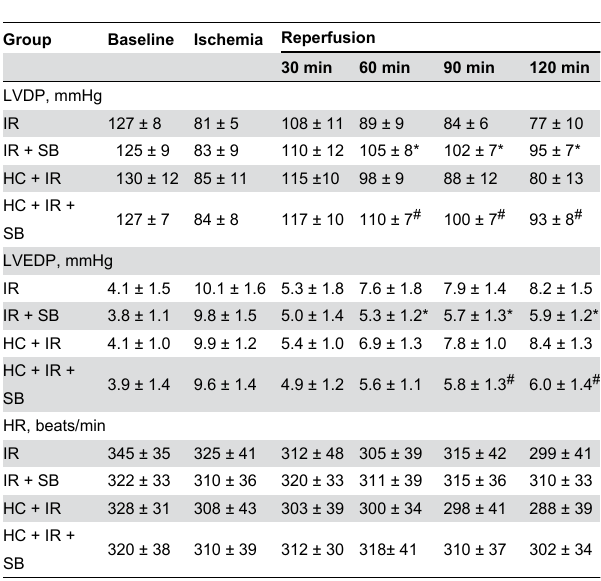
Effects of GSK3β inhibitor SB216763 on left ventricular hemodynamic parameters in rat hearts exposed to ischemia-reperfusion. IR: ischemia reperfusion; SB: SB216763; HC: hypercholesterolemia. Data are mean ± SD, n = 8 hearts/group. * P < 0.05 vs. IR, # P < 0.05 vs. HC + IR.